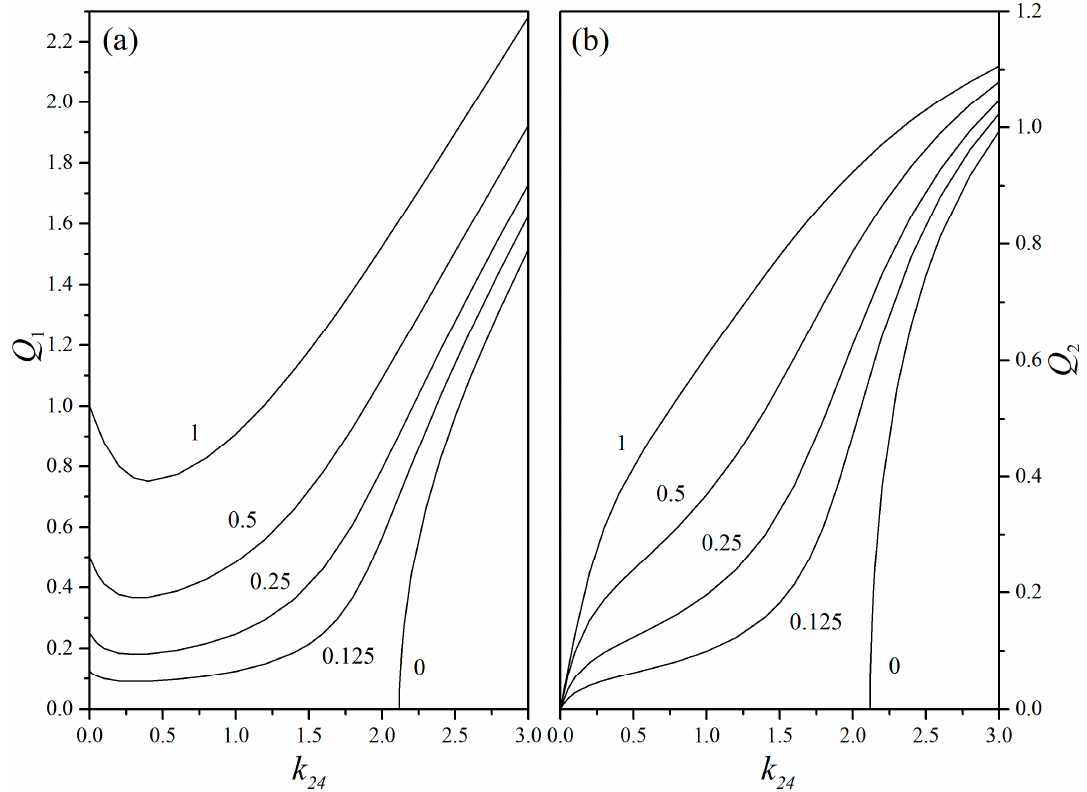
Figure 2. Dependence of equilibrium values of Q 1 ( a ) and Q 2 ( b ) on k 24 for five di ff erent values of the intrinsic chirality Q (denoted by numbers in graphs). Homeotropic anchoring, w = 1.